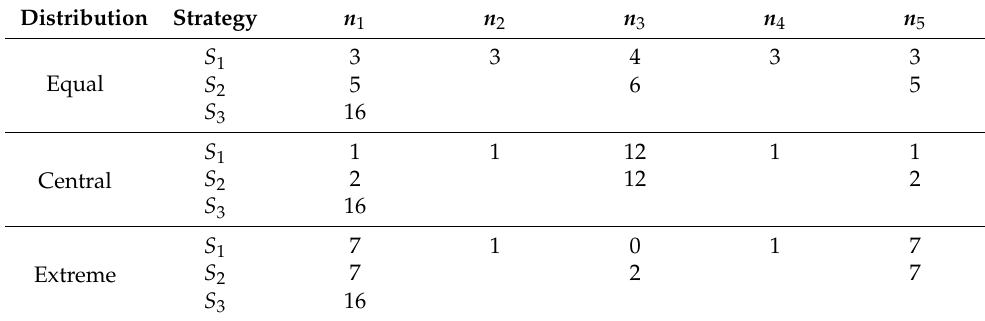
Table 3. Number of hoppers for each group according to the S 1 , S 2 , and S 3 strategies for equal, central, and extreme distributions with n =